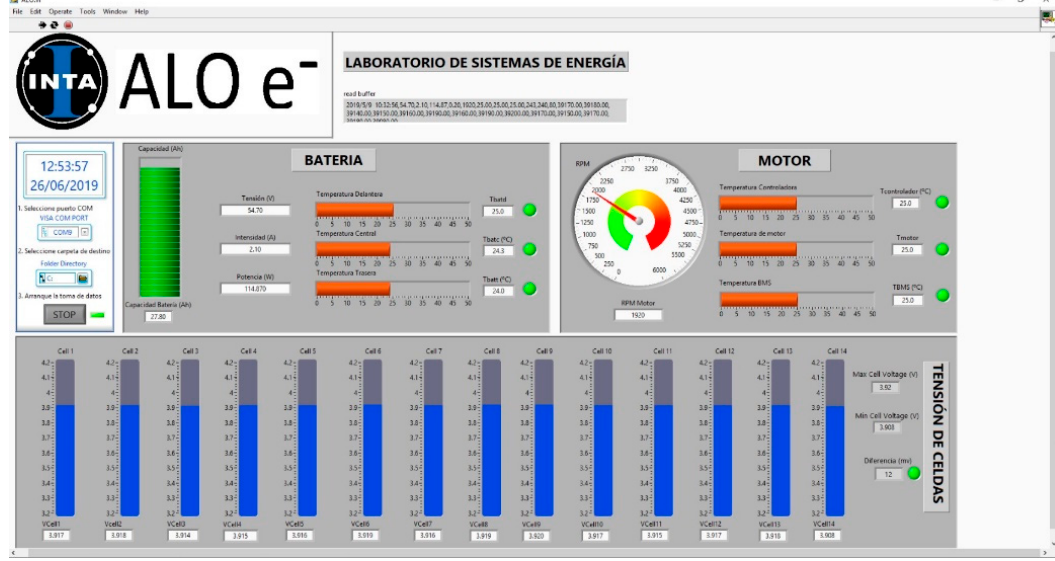
Figure 11. Developed SCADA software for electric ALO platform.